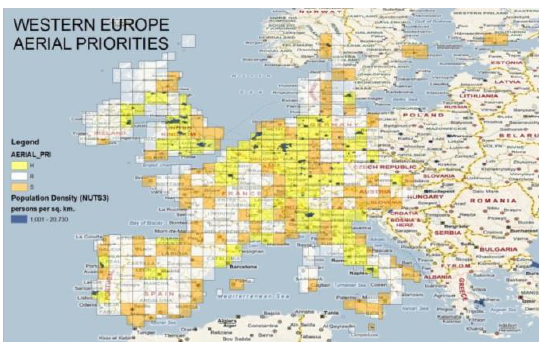
Figure 1: 1° grid in USA. Colors describe priorities by population density (H-high, S-standard, R-rural).